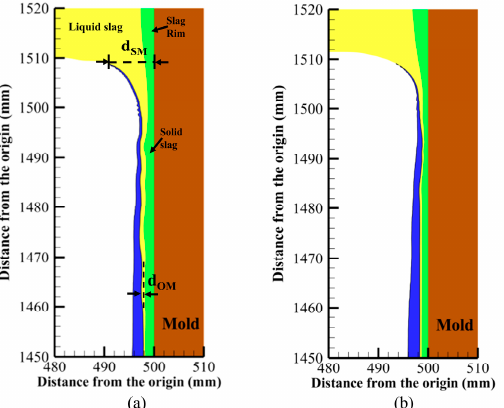
Figure 12. Influence of negative strip stage on meniscus solidification ( a ) with t n , ( b ) without t n . Table 3. Summary of results with and without 𝑡 (cid:3041) .